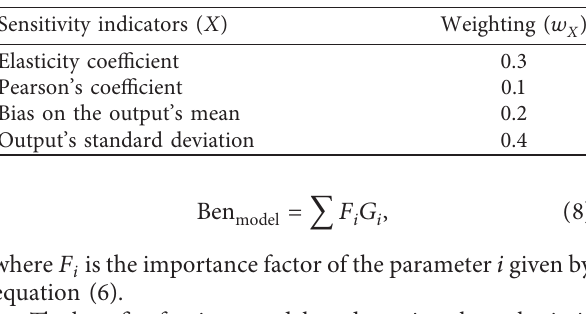
Table 18: Weighting